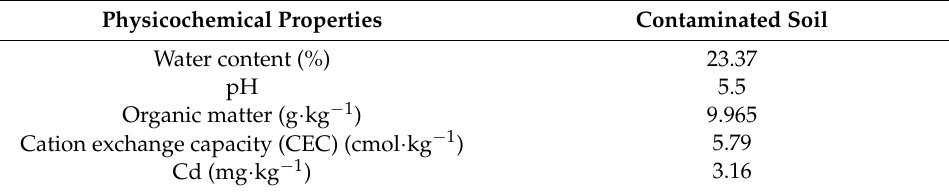
Table 1. Selected physicochemical properties of the contaminated